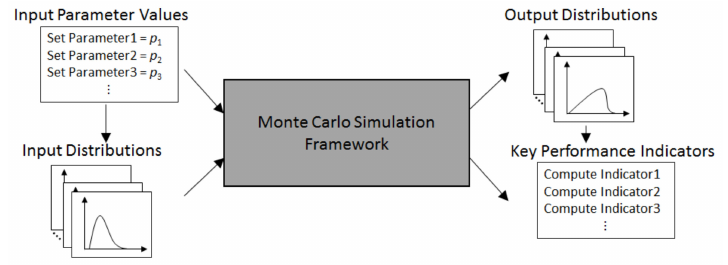
Figure 6. General representation of a Monte Carlo simulation